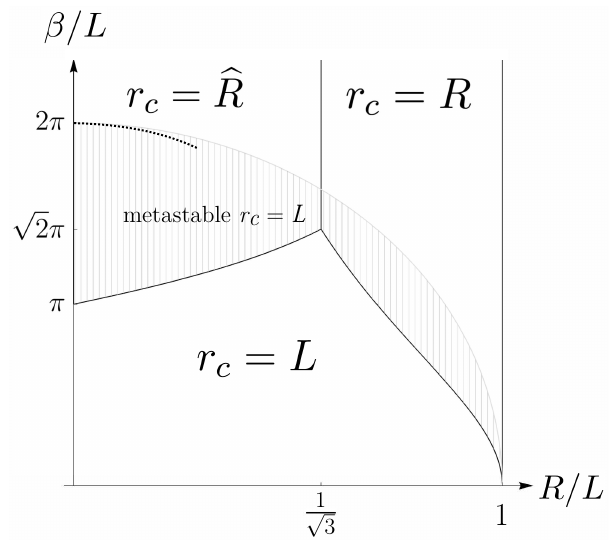
Figure 5 . The phase diagram for cosmological horizon patches in d = 4 spacetime dimensions, with boundary size R and inverse temperature β (figure adapted from [20]). The temperature on the upper (semicircular) boundary of the metastable r c = L region is the GH Tolman temperature at R . In the metastable region the configuration with r c = L is a local (endpoint) minimum of the action, while the absolute (endpoint) minimum has either r c = R or r c = b R , where b R is the radius of the other horizon when one horizon has radius R . The dotted path describes the R → 0 sequence of metastable de Sitter patches considered in the main body of this paper. Not shown are the black hole and thermal de Sitter phases, which have higher action along the dashed path